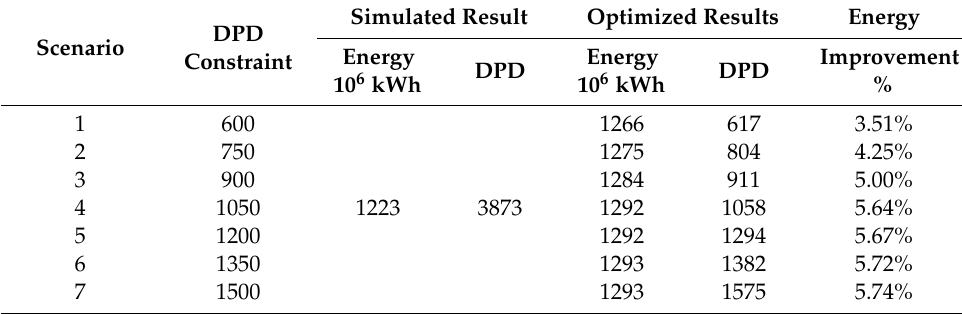
Table 4. Optimized annual hydropower production and maximum annual deficit percent day (DPD) of di ff erent water shortage